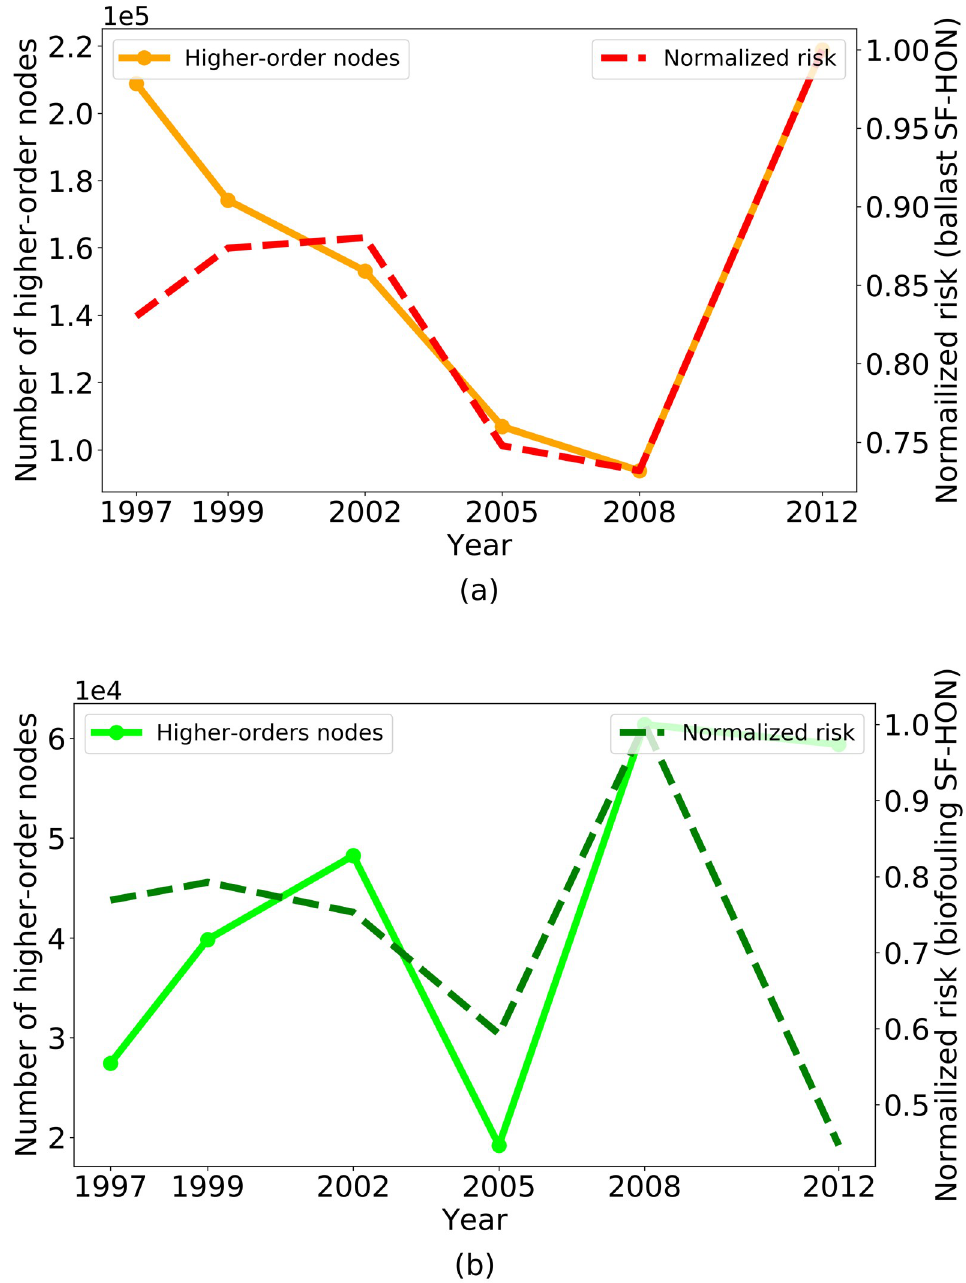
Fig 5. Variation of number of higher-order nodes and average NIS spread risk for (a) ballast SF-HON and (b) biofouling SF-HON. The average risk in both cases is normalized for easier comparison. In 2008 the average risk and number of higher-order nodes in ballast SF-HON drops, while they both increase in biofouling